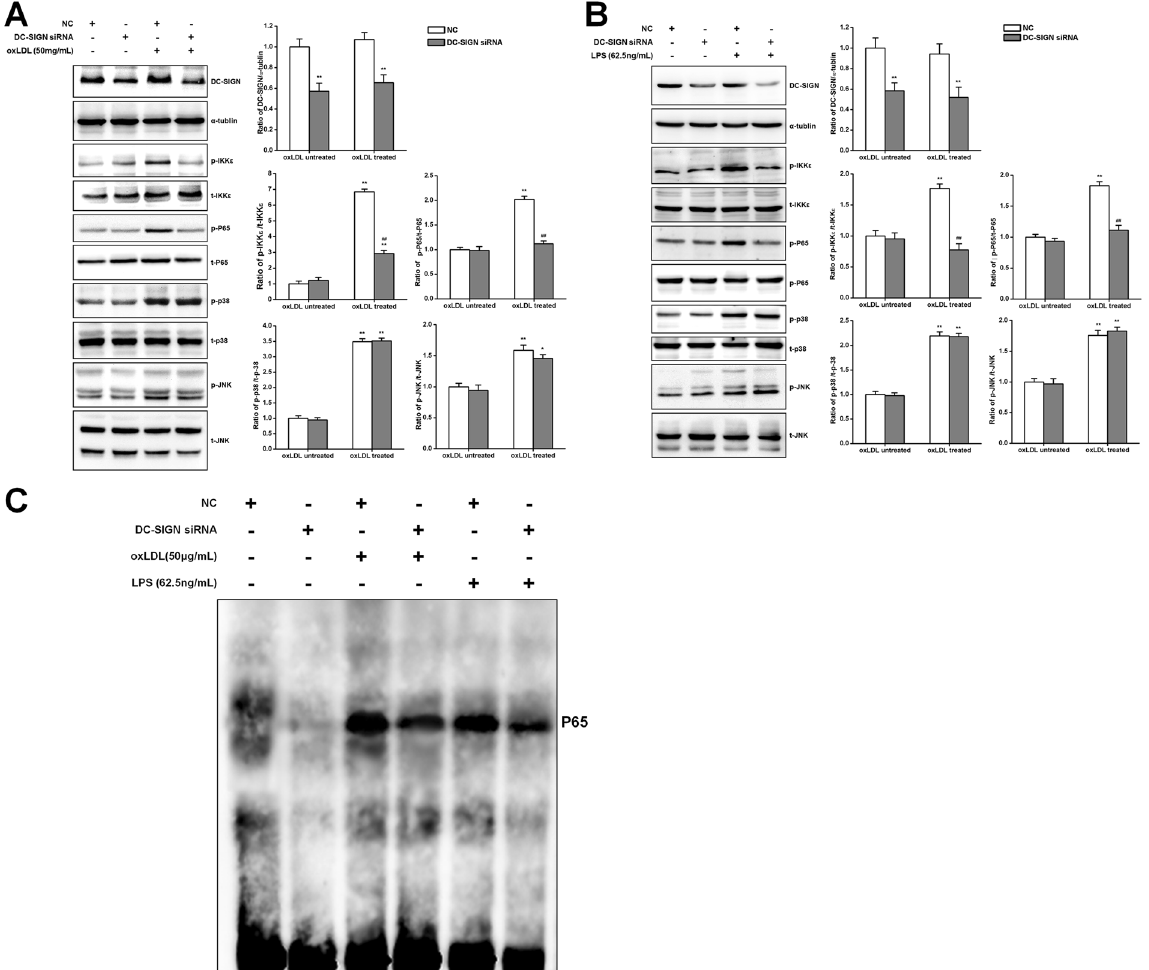
Figure 5. DC-SIGN participated in the TLR4-NF κ B pathway. Negative control (NC) or DC-SIGN siRNA was transfected into macrophages treated or not treated with oxLDL (50 μ g/ml) or LPS (62.5 ng/ml) for 60 min. Western blot analysis detected the knockdown efficiency of DC-SIGN and the phosphorylation of p38, JNK, IKK ε and NF κ B ( A and B ), which was quantified by densitometry in 3 independent experiments and presented as relative units (DC-SIGN/ α -tubulin, p38, JNK, IKK ε and NF κ B phosphorylated protein/total protein). The data are expressed as the mean ± SD from 3 independent tests. * P < 0.05, ** P < 0.01 compared with the macrophages not treated with oxLDL or LPS, ## P < 0.01 compared with the NC in the same group. ( C ) Negative control (NC) or DC-SIGN siRNA was transfected into macrophages treated or not treated with oxLDL (50 μ g/ ml) or LPS (62.5 ng/ml) for 60 min. Nuclear extracts were then prepared and assayed for p65 activation by